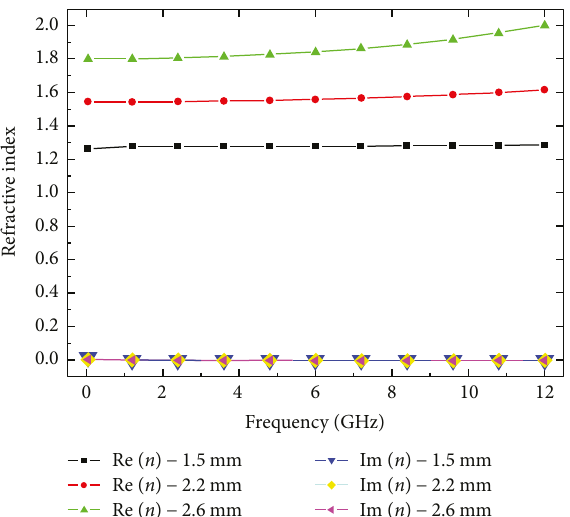
Figure 3: Refractive index of CSR for dimensions 1.5mm to 2.6mm.